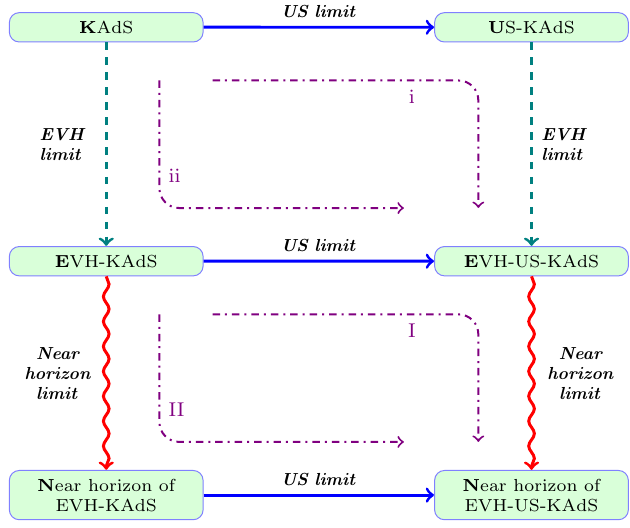
Figure 1 . Different order of limits for KAdS black